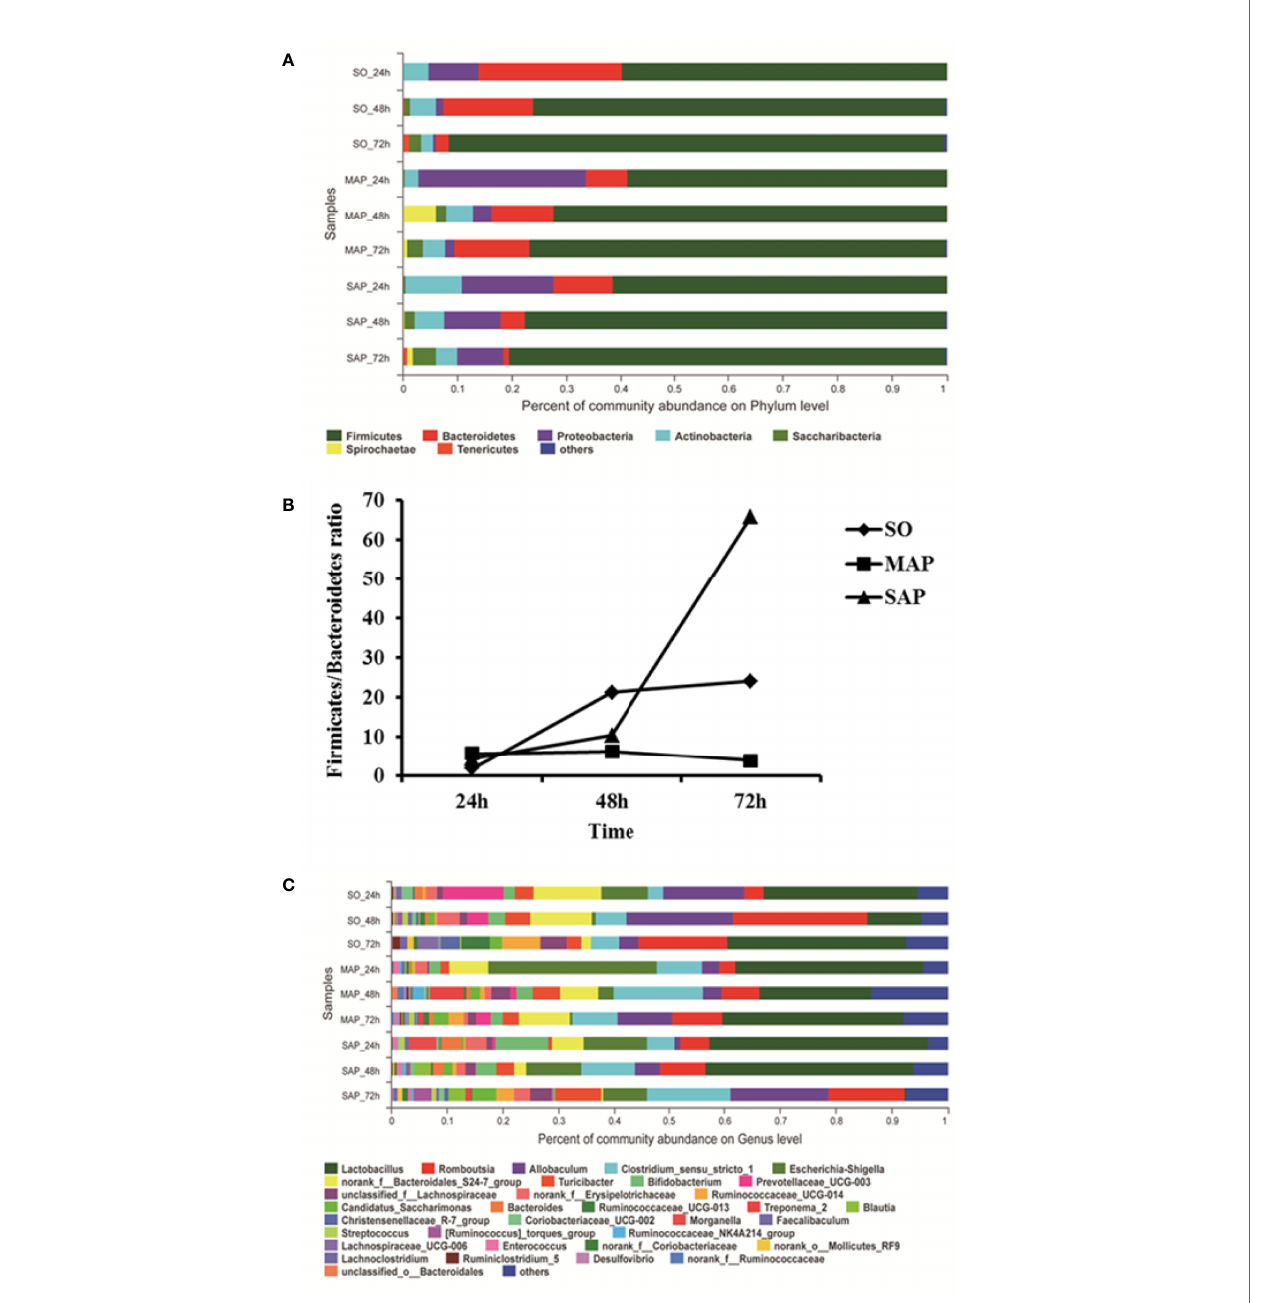
FIGURE 2 | Microbial community composition in fecal samples taken at three time points. (A) For each sample, the bar width of each phylum indicates the relative abundance of that phylum in the sample. (B) The Firmicutes/Bacteroidetes ratio of the three groups. (C) For each sample, the bar width of each genus indicates the relative abundance of that genus in the sample. SO, Sham operation; MAP, Mild acute pancreatitis; SAP, Severe acute